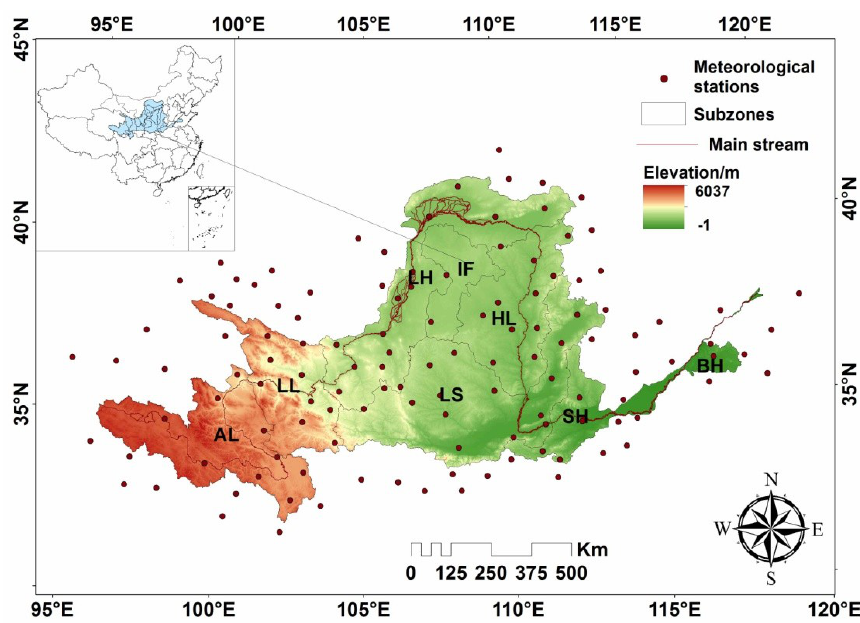
Figure 1. The location of the meteorological stations in the Yellow River basin (YRB).